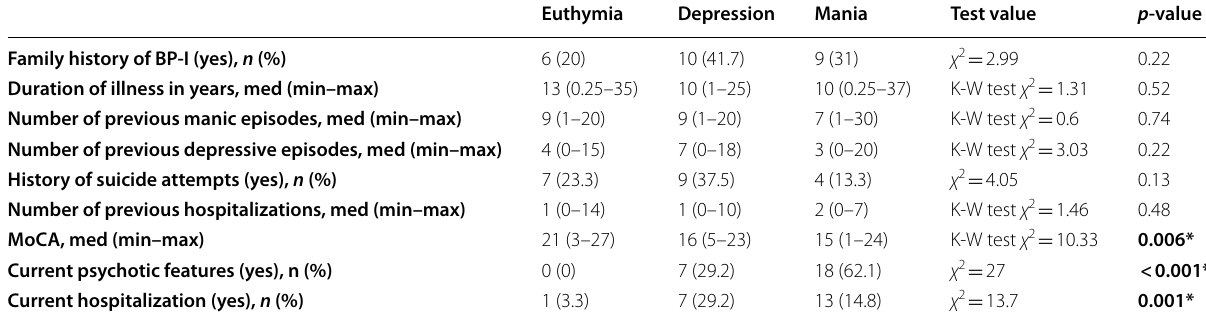
Table 2 Clinical characteristics of the BP-I